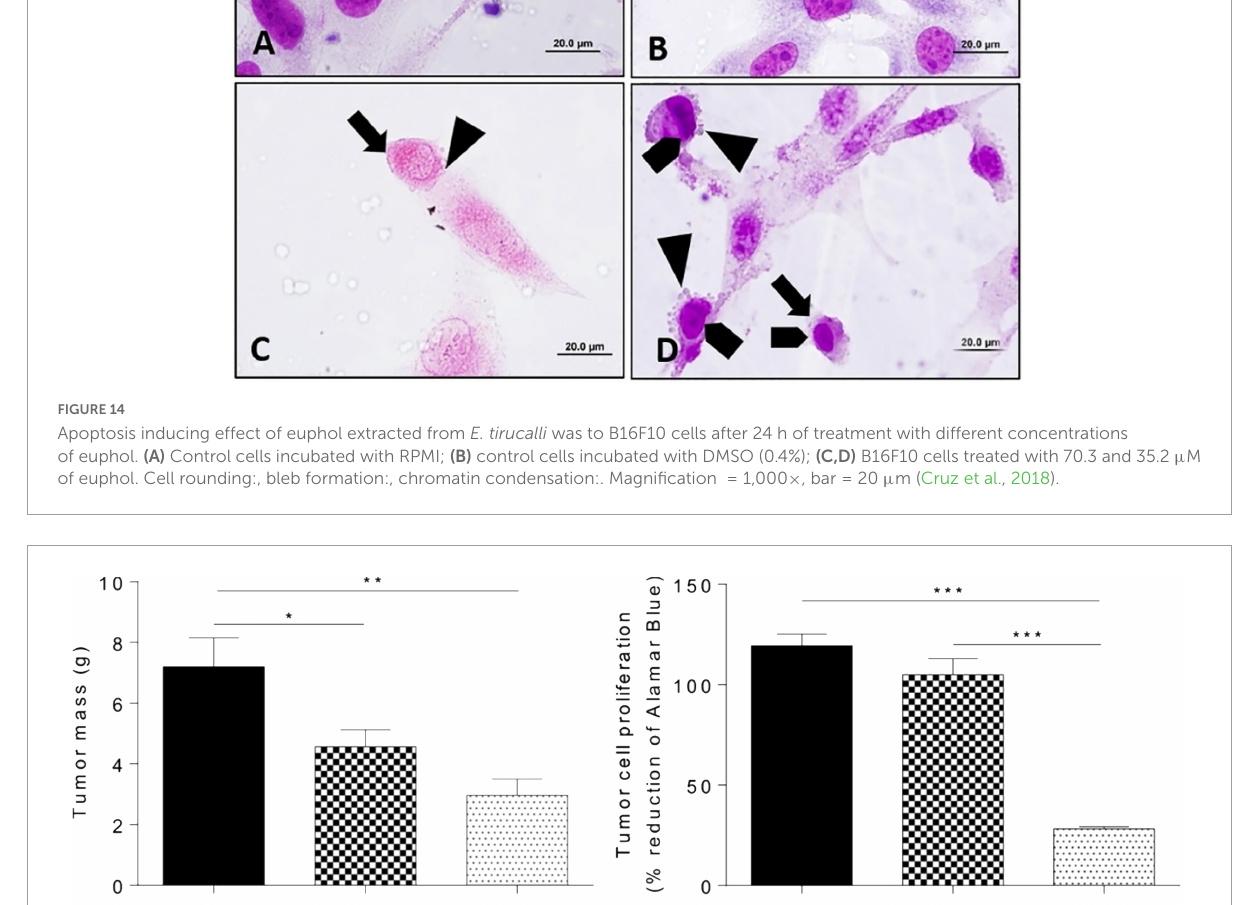
correlation with phenolic compounds and terpenoids